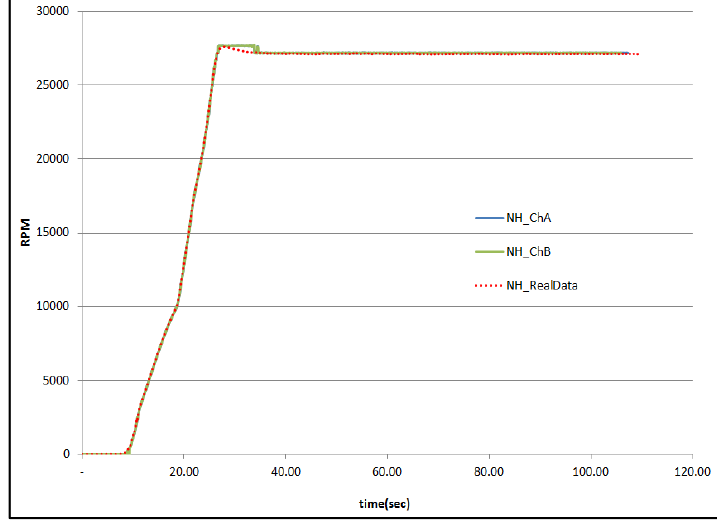
Figure 10. Result of startup phase performance test (NL).